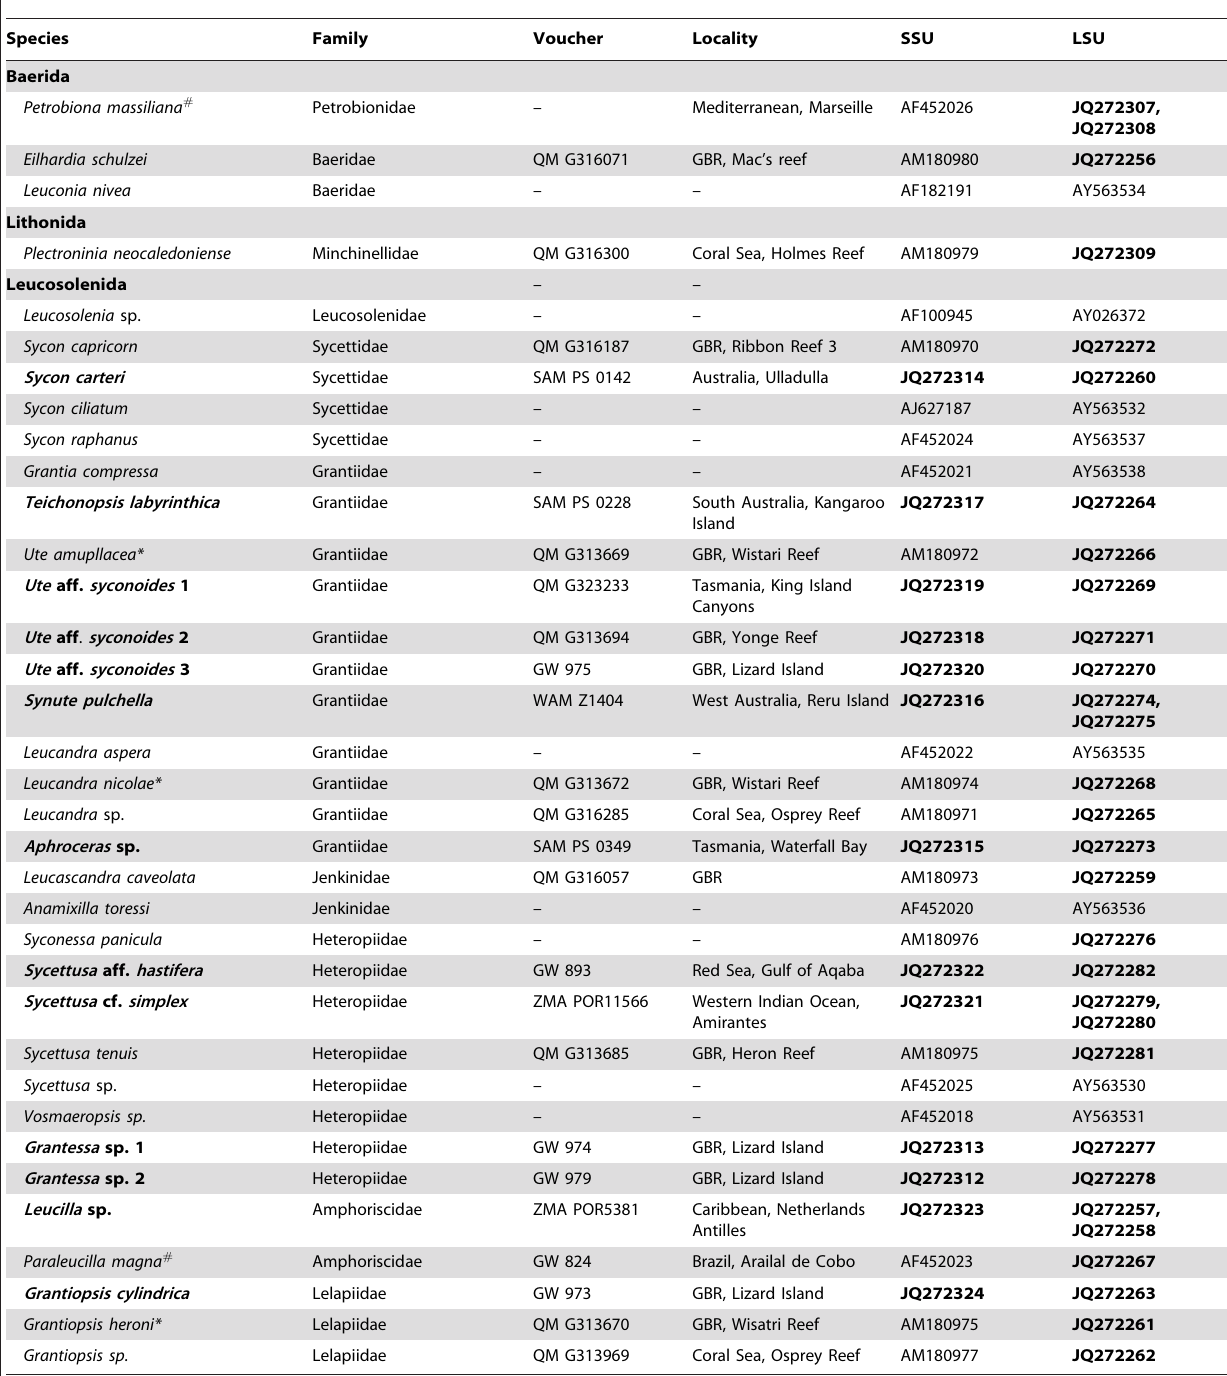
Table 2. Included specimens of Calcaronea, their sample localities and GenBank accession